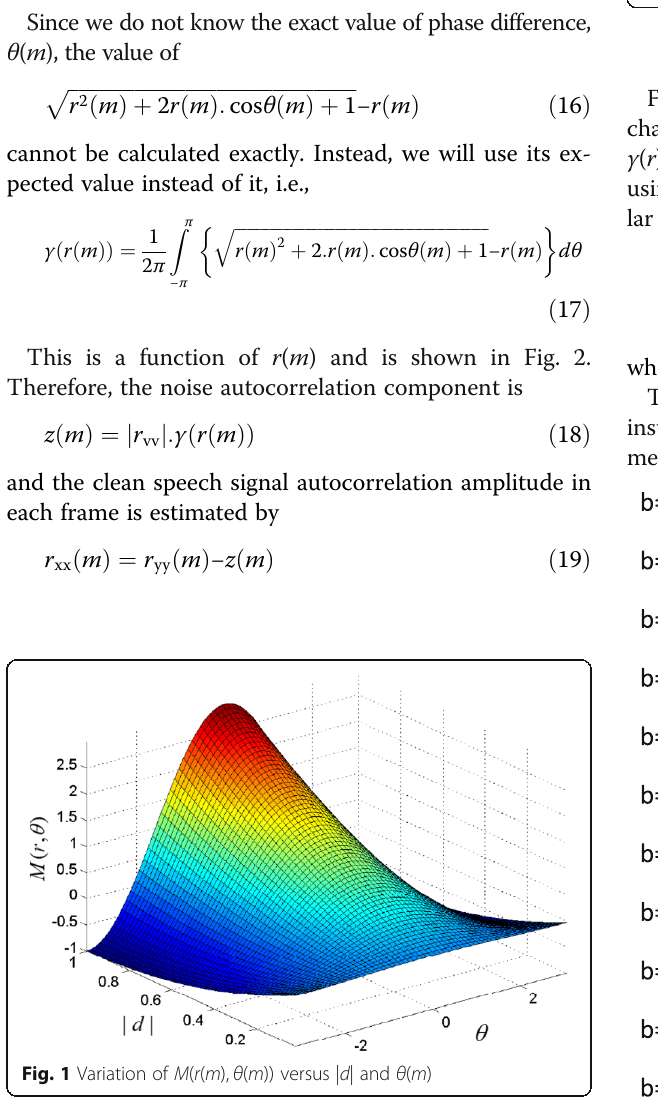
Fig. 2 Function γ ( r ). The bunch of curves represents the estimation of the function according to different values of b . The other curve represents the real values of γ ( r